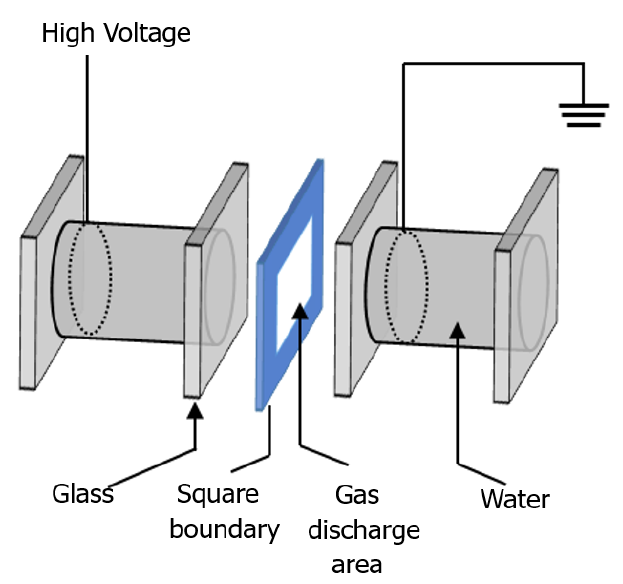
Figure 1. Schematic diagram of the experimental setup.